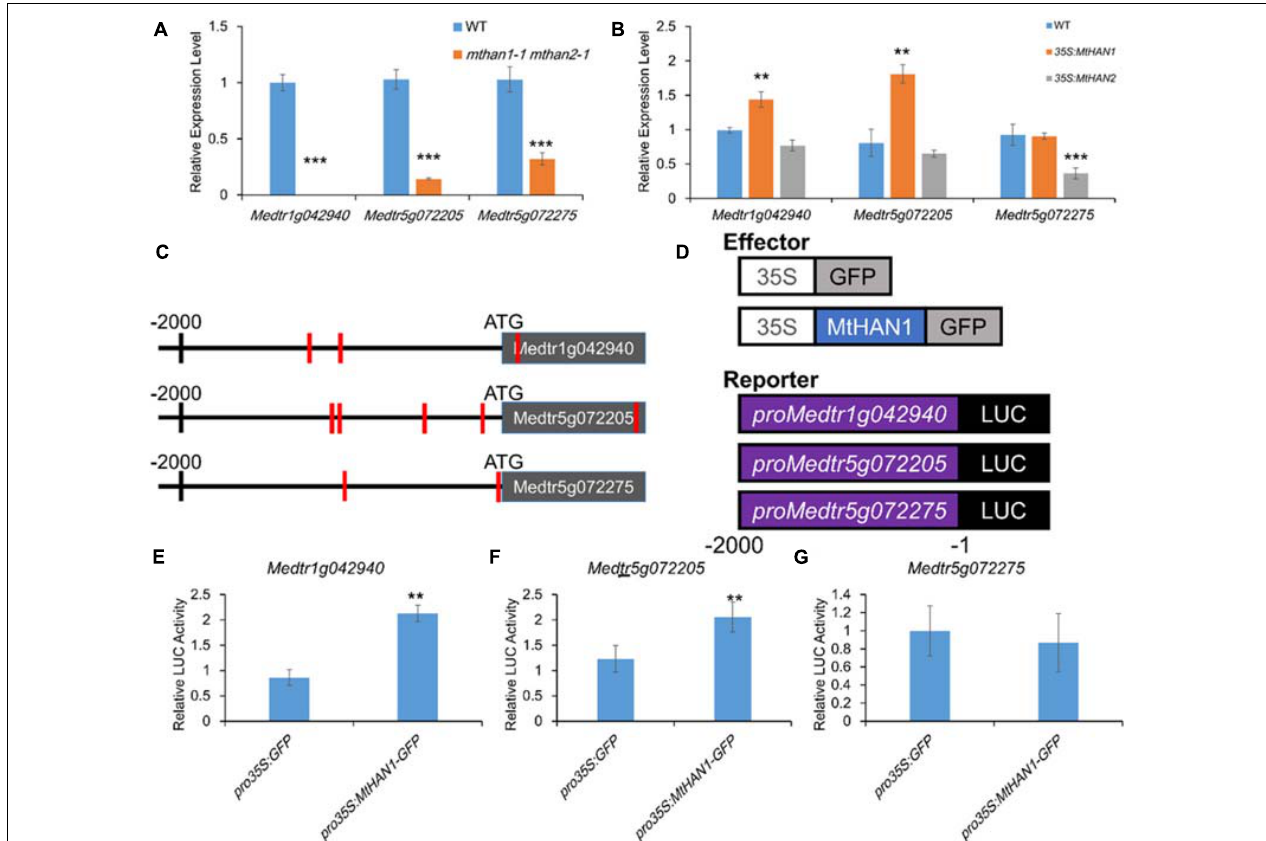
FIGURE 7 | MtHAN1 and MtHAN2 regulate the expression of three NCR genes (gene models Medtr1g042940 , Medtr5g072205 , and Medtr5g072275 ) in nodules. (A) Relative expression of NCRs in nodules of mthan1-1 mthan2-1 at 21 dpi. Values are the means ± SD of three biological replicates. *** P < 0.001. (B) Relative expression of NCRs in nodules of 35S:MtHAN1 and 35S:MtHAN2 at 21 dpi. Values are the means ± SD of three biological replicates. ** P < 0.01. (C) Schematic diagram of the genes corresponding to Medtr1g042940 , Medtr5g072205 , and Medtr5g072275 . Red vertical line indicates the MtHANs -binding motif (W-GATA-R). (D) Schematic structures of the effector and reporter constructs for the transient expression assay, in which GFP and MtHAN1 were under the control of the Cauliflower mosaic virus (CaMV) 35S promoter, the firefly luciferase ( LUC ) reporter gene was driven by NCR promoters ( Medtr1g042940 , Medtr5g072205 , and Medtr5g072275 ), and the Renilla luciferase ( LUC ; from Renilla reniformis ) gene driven by the 35S promoter was used as an internal reference. (E–G) MtHAN1 promotes the transcription of two NCRs (gene models Medtr1g042940 and Medtr5g072205 ) in a protoplast transient assay. The GFP protein was used as negative control. Mean and SD values were obtained from three biological replicates. ** P < 0.01, *** P < 0.001.